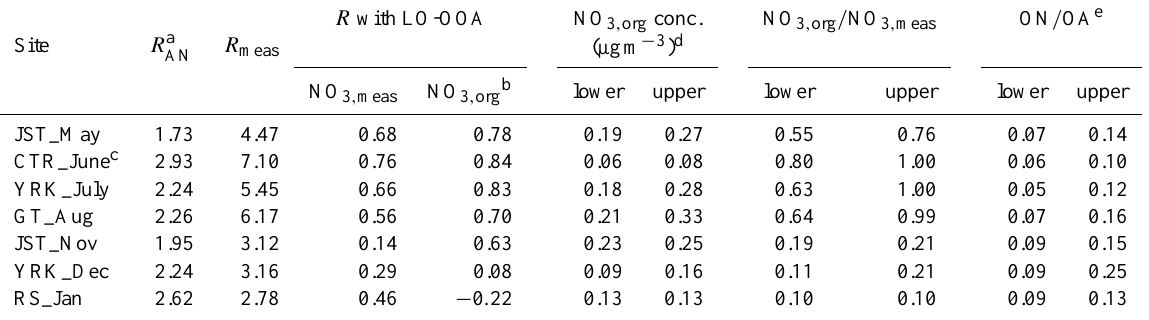
Table 2. A summary of organic nitrate estimations from the NO + x ratio method and the PMF method. R AN represents the NO + x ratio ( = NO + / NO + ) for pure ammonium nitrate (AN). R meas represents the NO + x ratio from observation. NO 3 , meas represents the total nitrate 2 functionality (from both organic and inorganic nitrates) as measured by the HR-ToF-AMS. NO 3 , org represents the nitrate functionality from organic nitrates, which is estimated from the NO + x ratio method. ON and OA represent organic nitrate and organic aerosol, respectively.